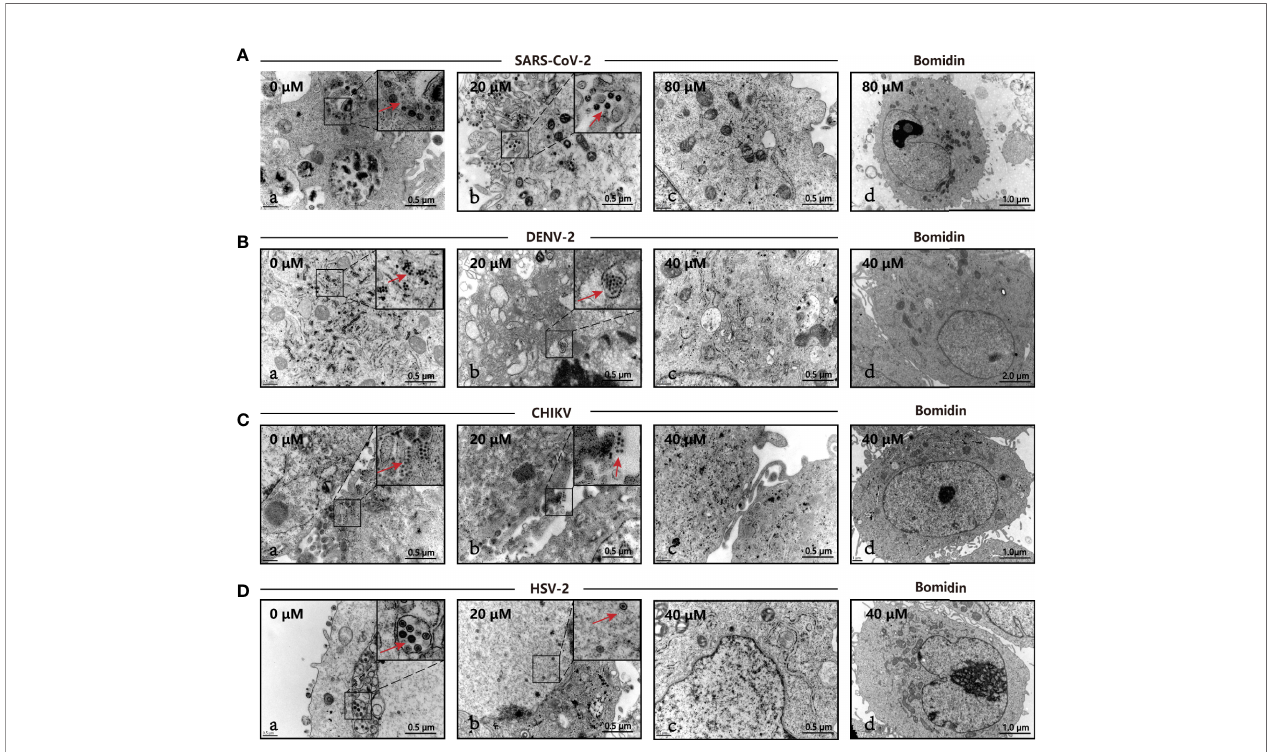
FIGURE 4 | The antiviral activity of bomidin against viral infection was determined by transmission electron microscopy (TEM). The different viruses were mixed with the respective concentrations of bomidin-treated cells for 2 hours and detected by TEM 48 h postinfection. (A) SARS-CoV-2, (B) DENV-2, (C) CHIKV, (D) HSV-2. (a) Virus-infected cells; (b, c) Bomidin-treated viral cultures for 10-30 min at 37°C with infected cells; red arrows: viral particles. (d) Bomidin